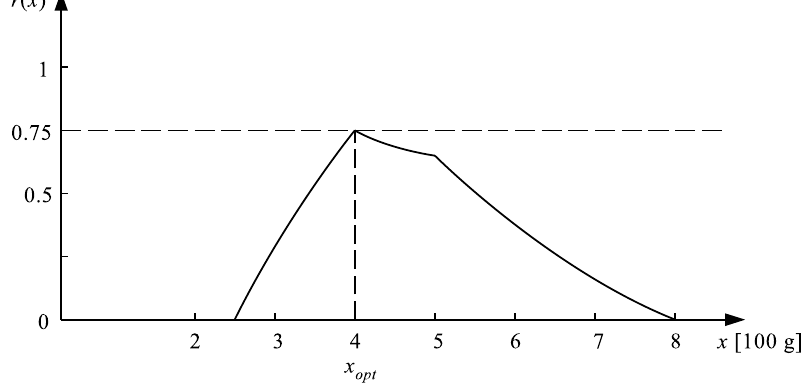
Figure 18. Robustness distribution r ( x ) of the solution x